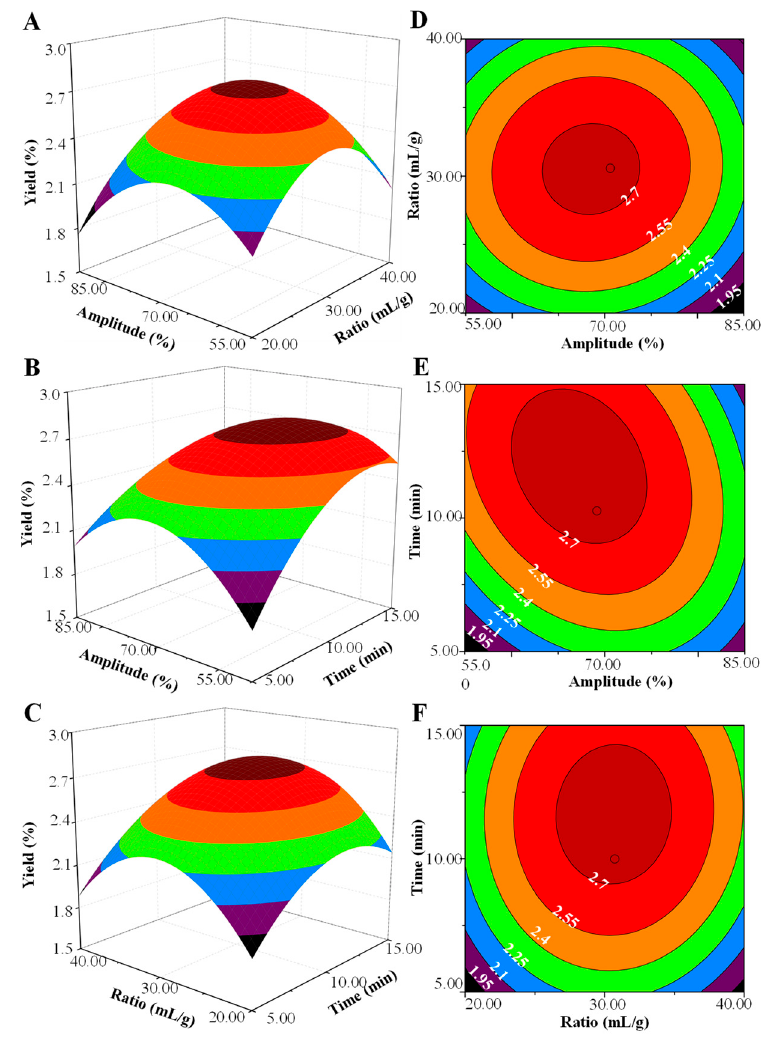
Figure 3. Three-dimensional response surface ( left ) and two-dimensional contour ( right ) plots of ultrasonic-assisted extraction. ( A , D ) ultrasonic amplitude and ratio of water to raw material; ( B , E ) ultrasonic amplitude and ultrasonic extraction time; ( C , F ) ratio of water to raw material and ultrasonic extraction time.